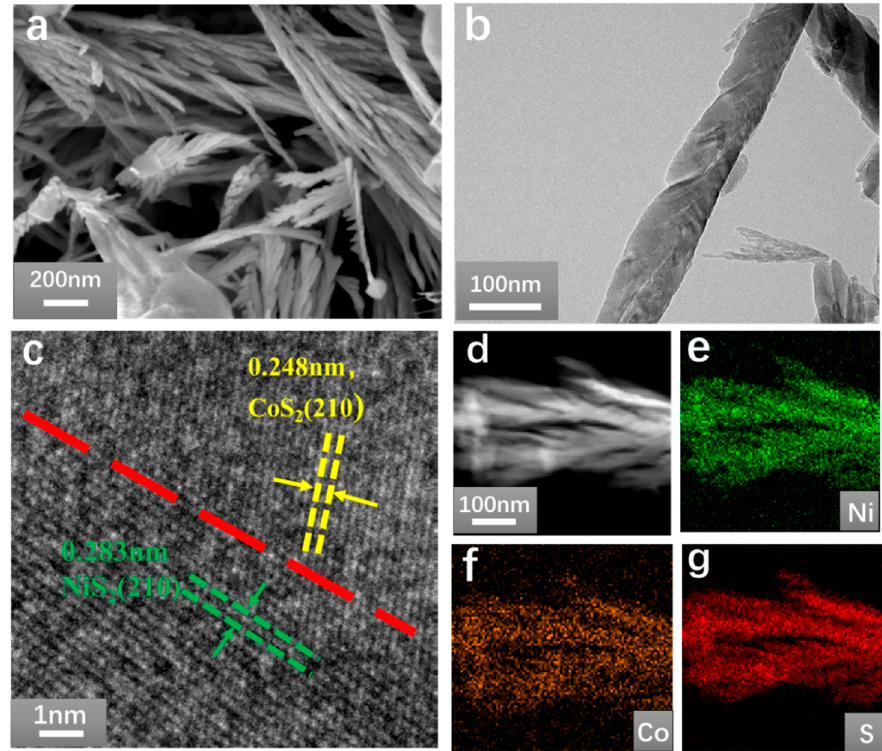
Figure 2. ( a ) SEM images of Co-NiS 2 /CoS 2 heterostructures; ( b ) TEM image of Co-NiS 2 /CoS 2 heterostructures; ( c ) HRTEM image of Co-NiS 2 /CoS 2 heterostructures; ( d – g ) STEM image and EDXA elemental mapping of Ni, Co, and S for Co-NiS 2 /CoS 2 heterostructures. By means of EDXA and XPS (X-ray photoelectron spectroscopy), the chemical compo- sition and valence state of Co-NiS 2 /CoS 2 were further understood. Figure 3a shows the complete XPS spectrum of 27% Co-NiS 2 /CoS 2 heterostructures. The peaks observed at 854.2 eV and 855.7 eV are attributed to Ni2p3/2 and Ni2p1/2 of Ni 2+ , respectively, and the peaks at 871.9 eV and 875.5 eV are attributed to Ni2p3/2 and Ni2p1/2 of Ni 3+ , respectively. The existence of NiS 2 was further confirmed by the peaks of Ni 2+ and Ni 3+ and the satellite peaks of 861.7 eV and 879.6 eV (Figure 3b) [34,35]. As the XPS spectrum of Co is shown in Figure 3c. The Co 2p spectrum was deconvoluted to three spin–orbit doublets. The